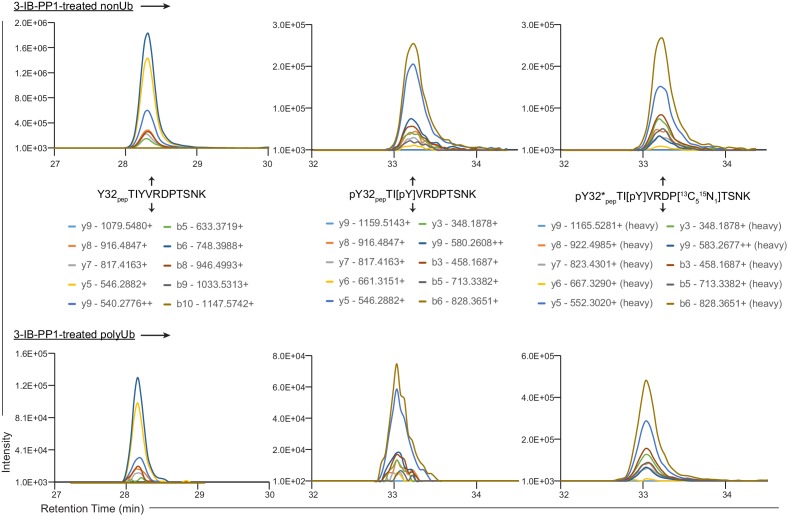
Annotated XICs.XICs from Figure 4C showing charge states and m/z values for y and b fragments from Y32 pep, pY32 pep, and pY32*pep.